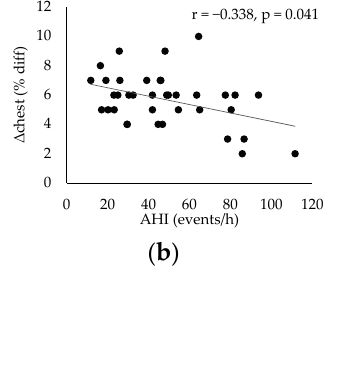
( f ) ( g ) Figure 1. Correlation analysis results between apnea hypopnea index (AHI) and reactive oxygen metabolites’ levels (d-ROM) ( a ), chest circumference difference between maximal inhalation and exhalation ( Δ chest) ( b ), neck circumference ( c ), meters during 6 min walk test (6MWT) ( d ), estimated oxygen uptake (VO 2 ) ( e ), metabolic equivalent (MET) ( f ) and dyspnea at the end of 6MWT ( g ). Figure 2. Oxidative stress marker on reactive oxygen metabolites’ levels (d-ROM) between groups.